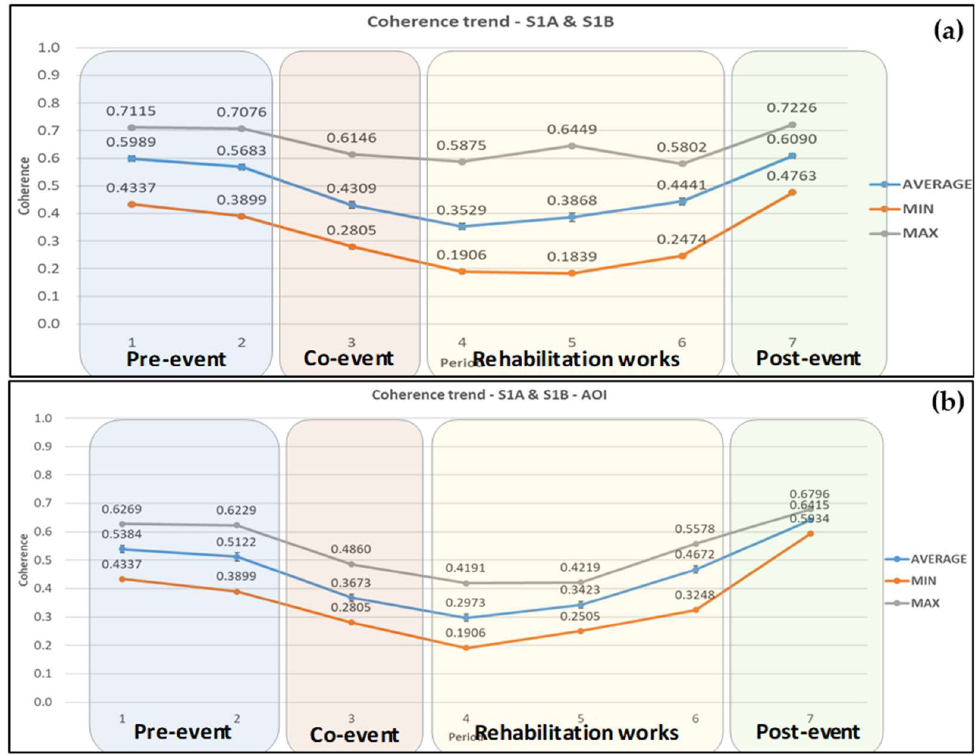
Figure 10. Average coherence changes obtained from Sentinel-1A and 1B ascending and descending satellite images for ( a ) the wider area and ( b ) the AOI. Error bars can be seen in the average coherence values.